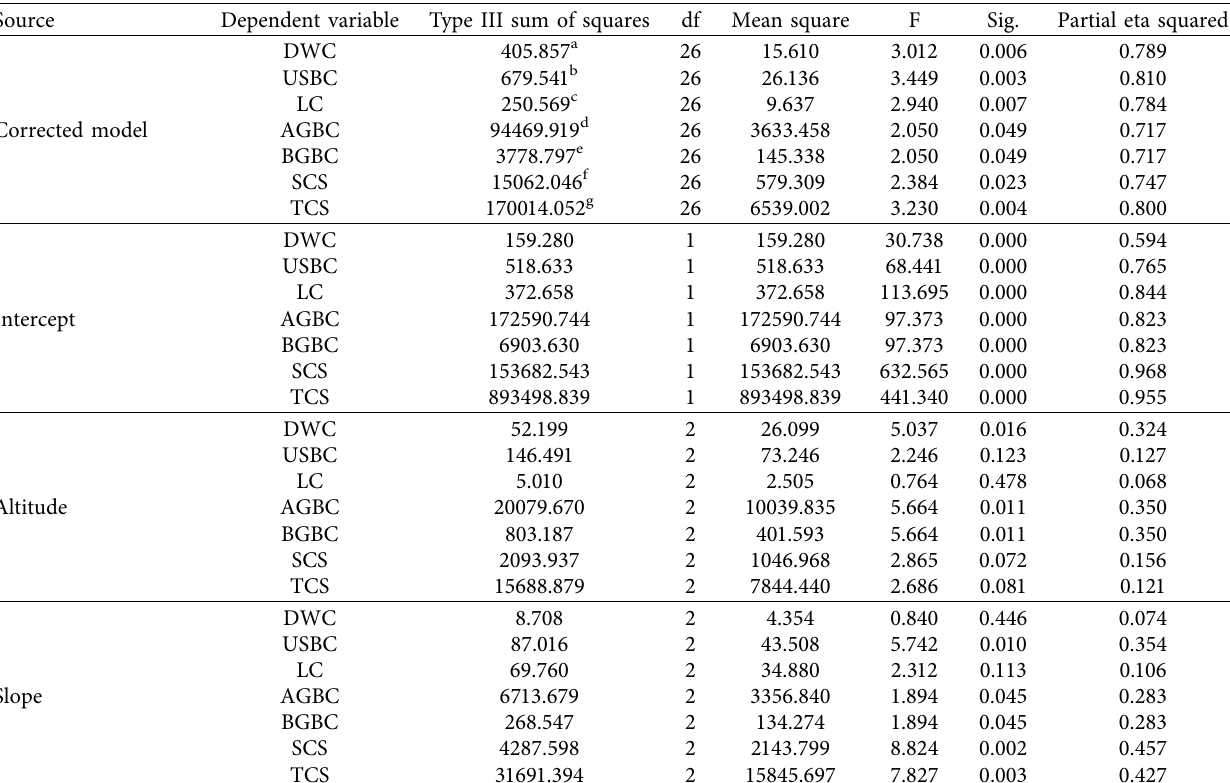
Table 10: Tests of between-subject effects in Ziba